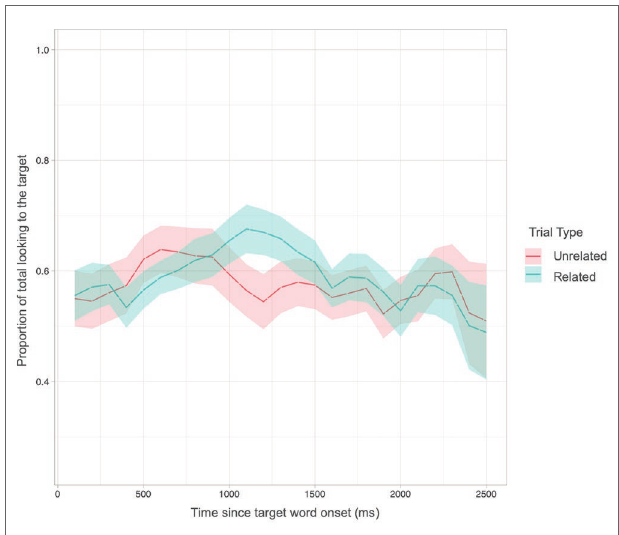
FIGURE 6 | Proportion of looks to the target for related and unrelated trials over time at 24